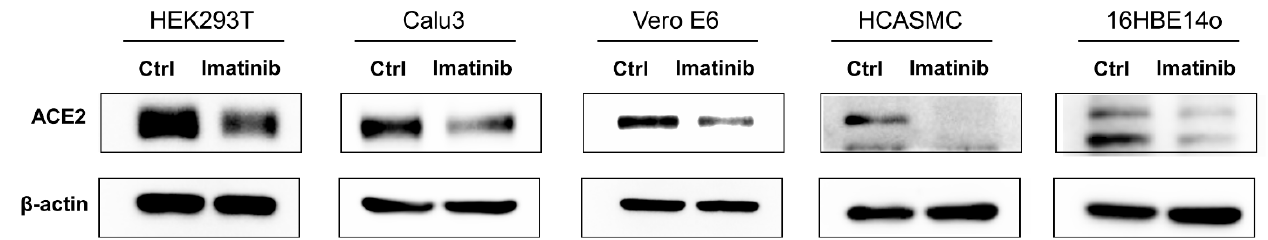
Figure 3. Treatment with imatinib suppressed ACE2 protein expression in multiple cell lines. Cell lysates of the indicated cell lines treated with and without imatinib (at 5 µ M for 24 h) were isolated and analyzed by Western blotting using an anti-ACE2 polyclonal IgG. The expression of β -actin was used as the internal equal loading control.